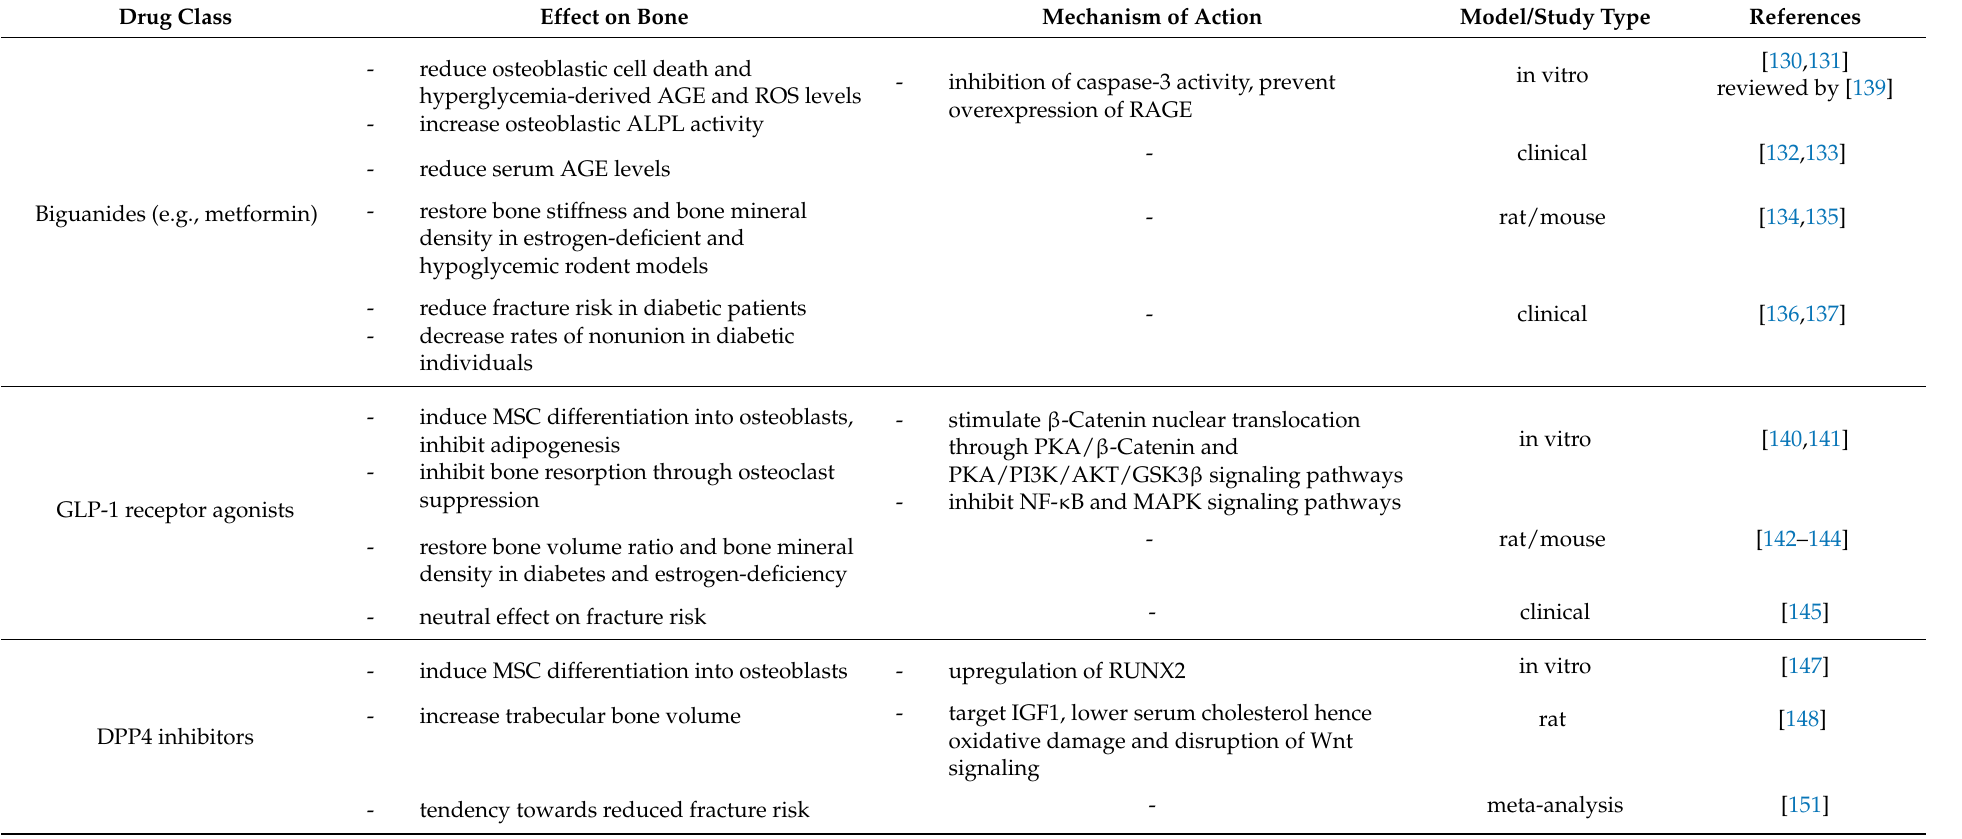
Table 1. Effects of antidiabetic drugs on bone: experimental and clinical